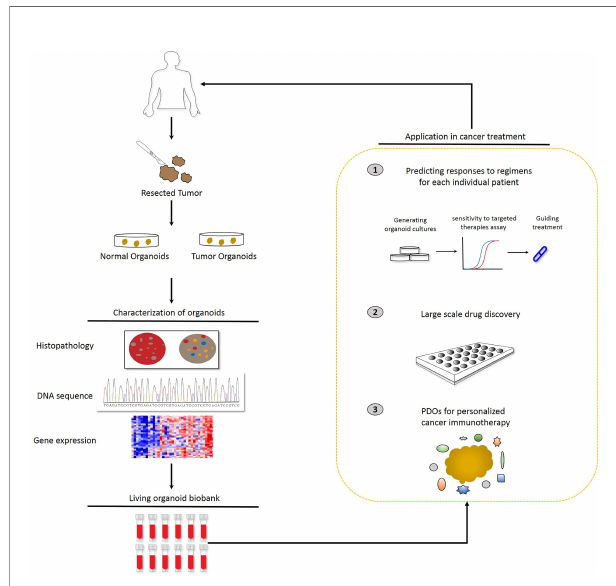
FIGURE 1 | Potential applications of patient-derived organoids (PDOs). Identi fi cation of PDOs was performed via next-generation sequencing and comparison with the histology and pathology of the parental tumors. PDOs are suitable for drug sensitivity testing and drug selection to predict patient response and guide treatment at the individual level. In parallel, PDOs will be preserved as a living cell biobank and the organoid model is accessible for precision